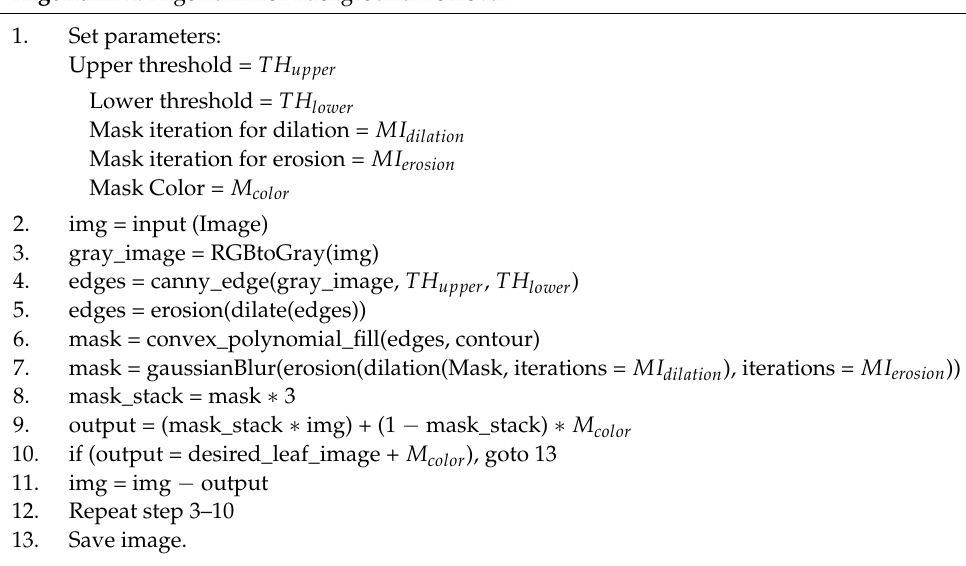
Algorithm 2. Algorithm for Background Removal